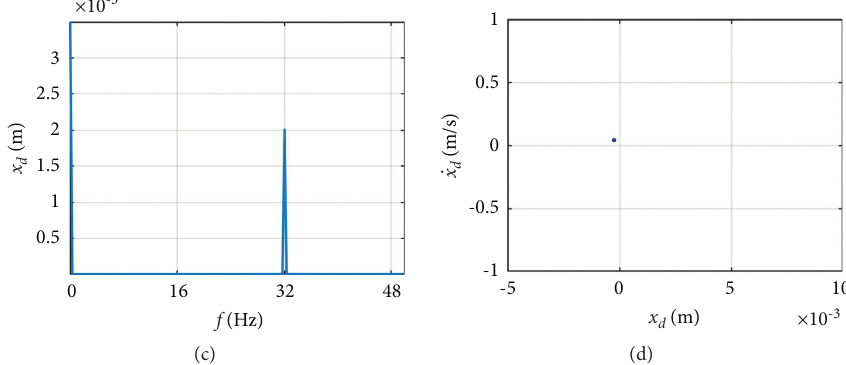
� 70 ) MN/m: (a) time history, (b) phase diagram, (c) frequency spectrum, and (d) s